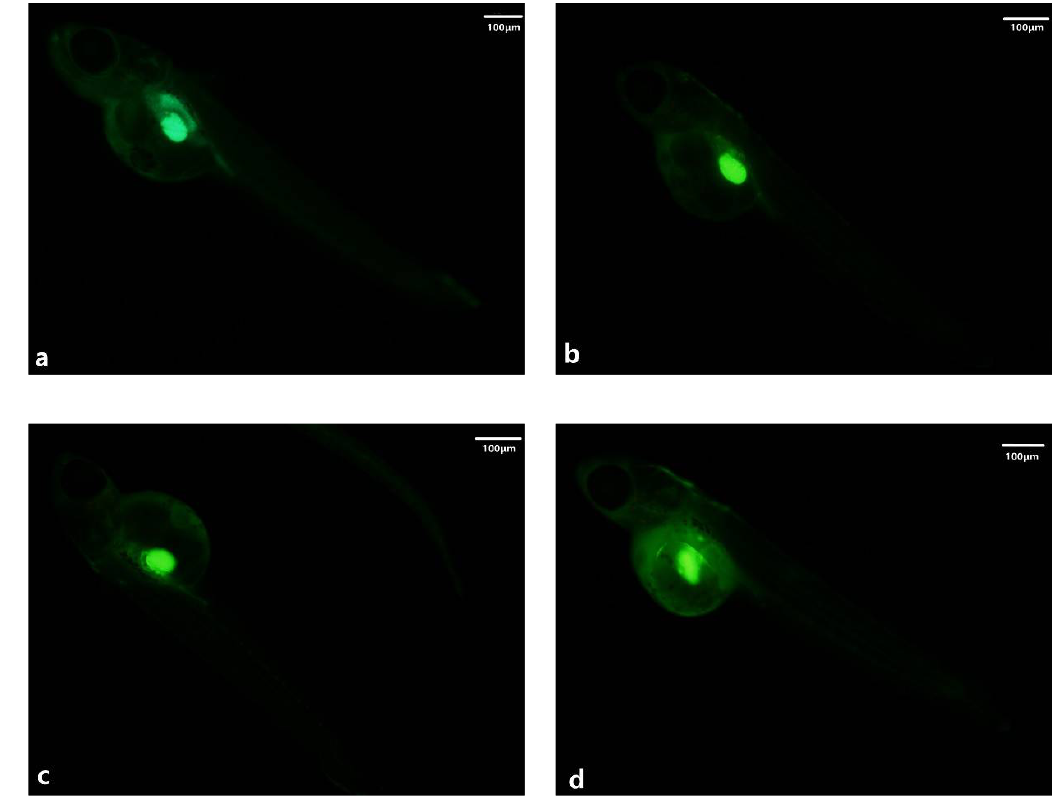
Figure 3. ROS content in newly hatched larvae of medaka. ( a – d ) Level of ROS in larvae after the addition of 0, 0.2, 0.5, and 2 g/L PAC-MC, respectively, for 6 h.